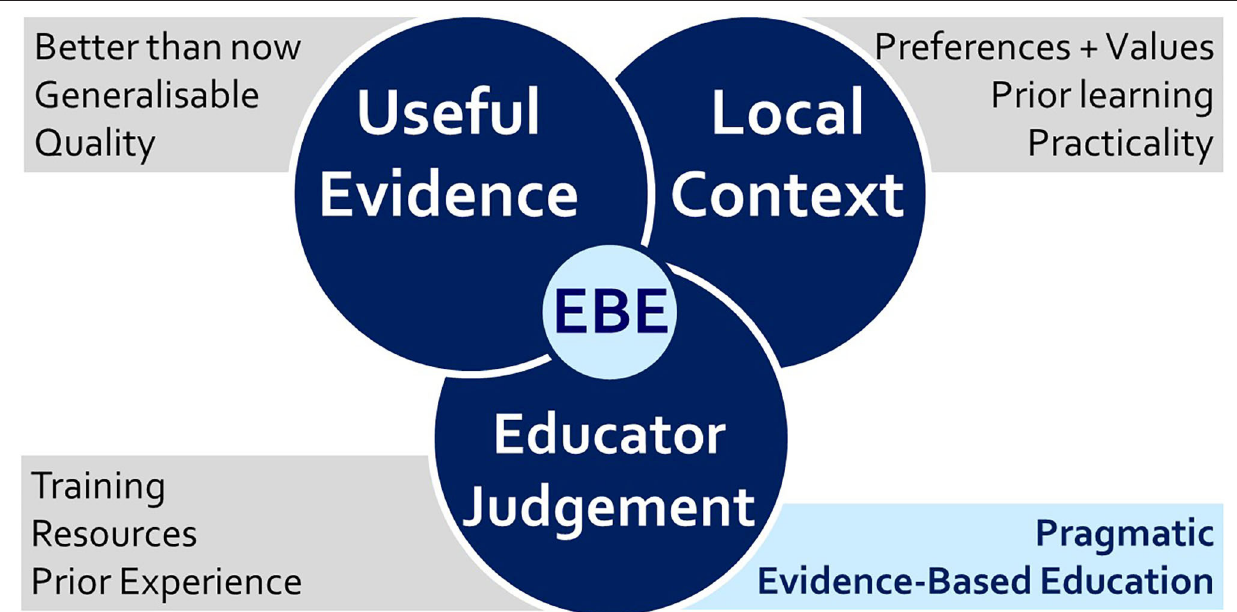
FIGURE 1 | A Model of Pragmatic, Evidence-Based Education. A decision-making model for the application of research evidence to improving educational practice. The most useful research evidence is combined with practitioner judgement about how and why to apply it in a specific context, with specific questions for each aspect. At the intersection of these three factors is Pragmatic Evidence-Based Education